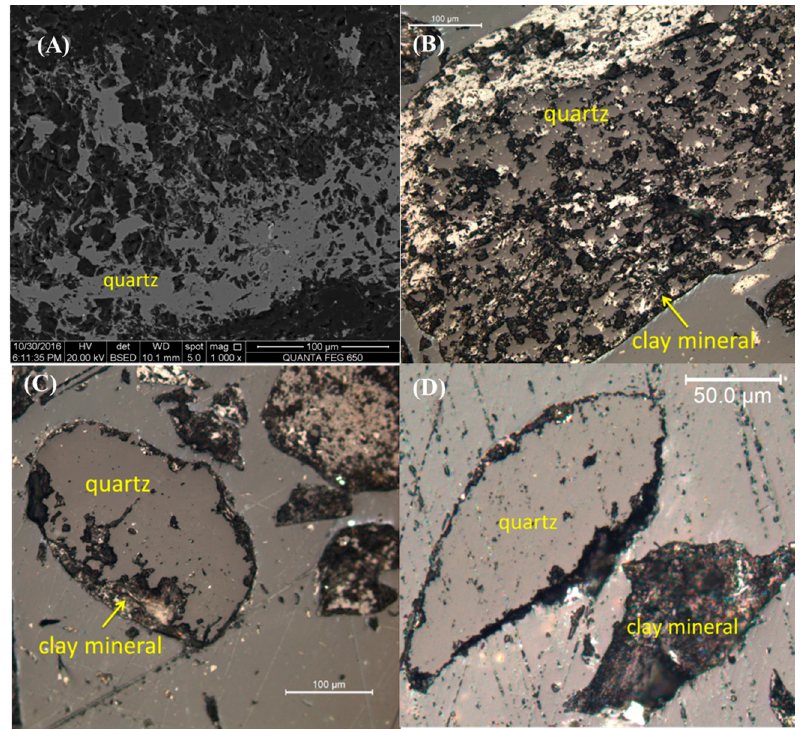
Figure 12. Quartz in the coal and non-coal samples. ( A , B ) Massive quartz in SGT1-9 and SGT1-3 samples; ( C , D ) detrital quartz coated by clay mineral in SGT1-3 and SGT1-1 samples; ( A ) is a SEM back-scattering image; ( B – D ) are under optical microscopy (reflected light).